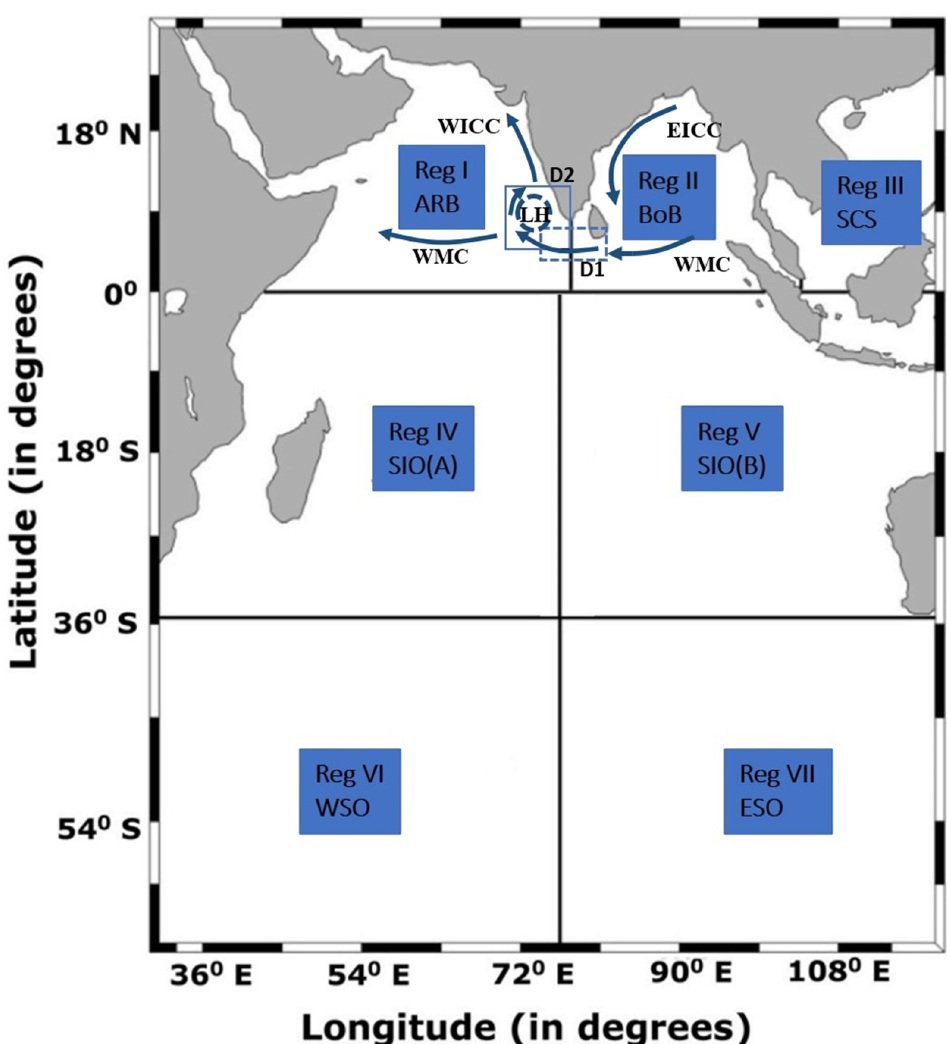
Figure 1. The map of Northern Indian Ocean region showing the study regions marked I-VII and D1